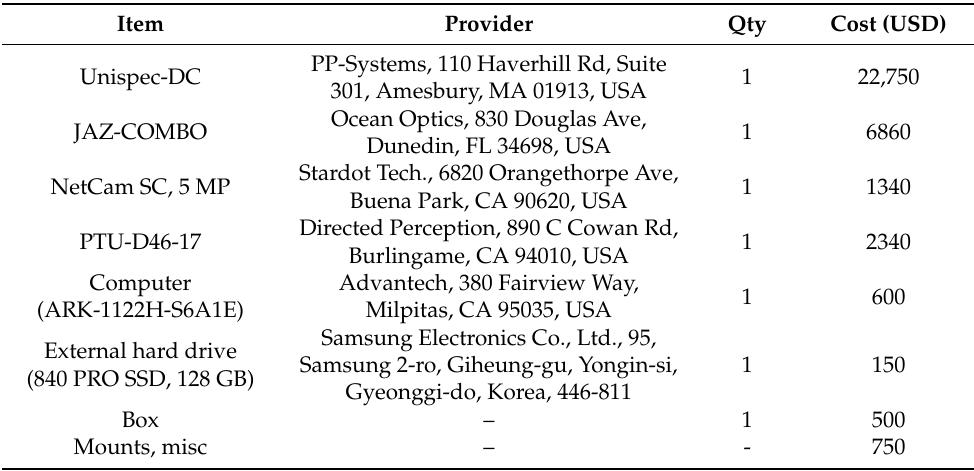
Table 2. AMSPEC-III components and approximate